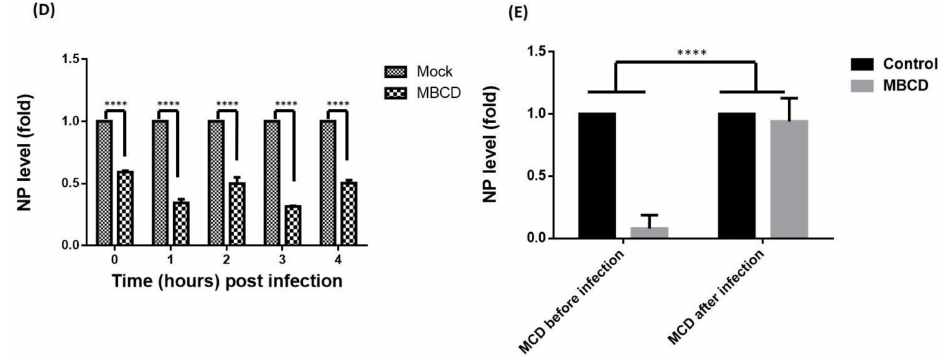
Figure 3. Exploitation of raft-dependent endocytosis by IAV for host internalization. ( A ) Confocal images of mock or MBCD treated, IAV infected (37 ◦ C) A549 cells with indicated time of post IAV infection. Internalized IAVs were detected by staining with anti-NP-FITC antibody. ( B ) Analysis of IAV internalization via Western blot in mock or MBCD treated A549 cells showing drastic reduction in IAV entry in MBCD treated cells. Actin served as an internal control. ( C ) Flow cytometric analysis of IAV endocytosis in mock versus MBCD treated A549 cells. **** p < 0.0001, calculated by two way ANOVA. Error bars show ± SD. ( D ) . Relative quantitation of NP a central core of RNA genome (vRNA) by qRT-PCR. **** p < 0.0001, calculated by two way ANOVA. Error bars show ± SD. ( E ). Relative quantitation of NP vRNA in A549 cells that were MBCD treated before IAV infection and MBCD treated after IAV infection. **** p < 0.0001, calculated by two way ANOVA. Error bars show ±